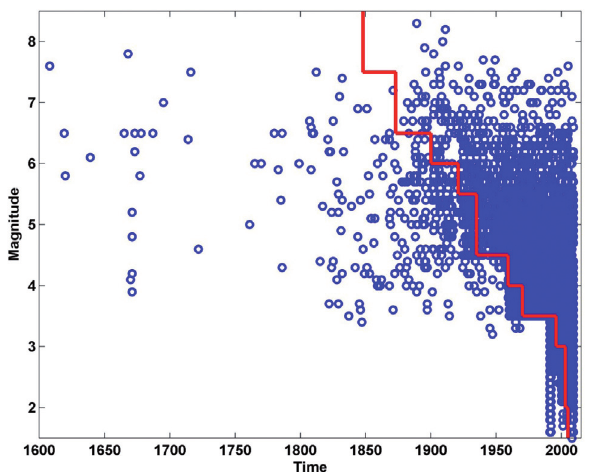
Figure 10. Completeness analysis (red line) for the EMCA catalogue (blue circle) considering MLH magnitude.